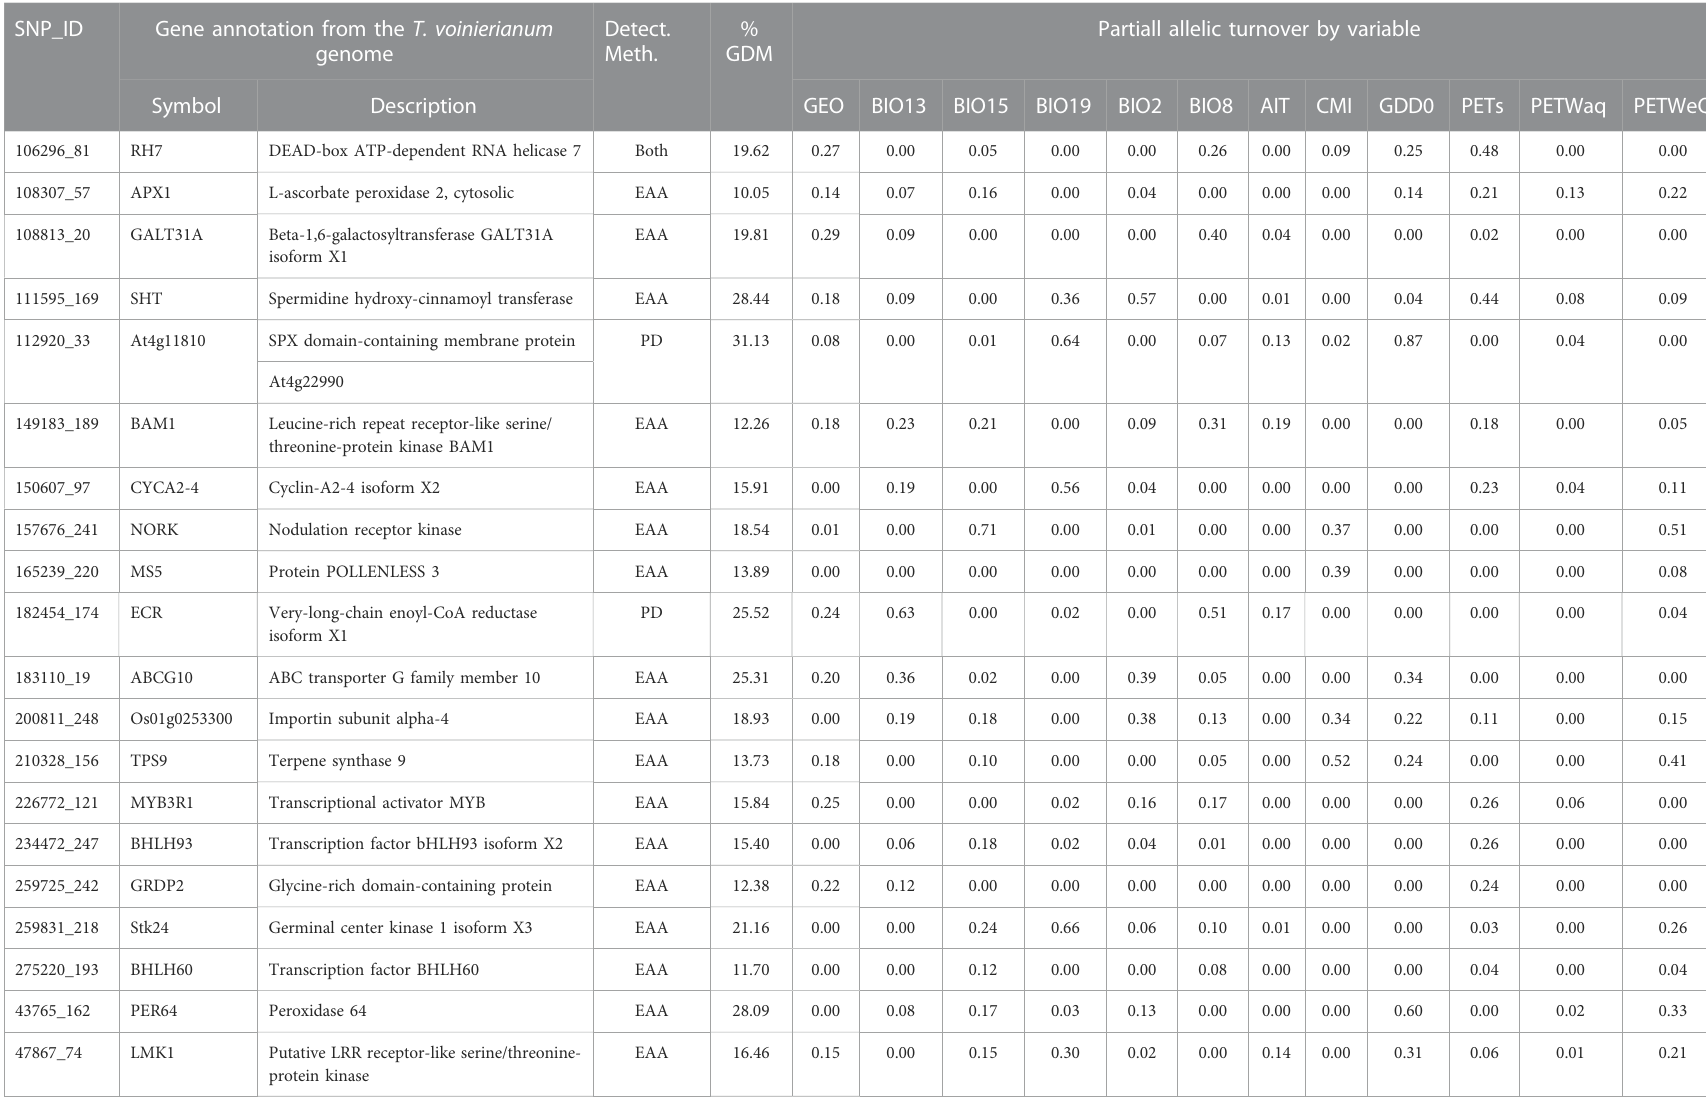
TABLE 3 Gene annotation and associated variables for potentially adaptive SNPs. SNP IDs, gene function on the T. voinierianum genome are shown. The detection method (PD/EA tests) and partial allelic turnover by variables predicted by GDM are listed for each annotated locus. The SNP presented had 1) higher allelic turnover responses associated with climate variables relative to geographic distance, and 2) a higher explained deviance (%) in GDMs than the reference SNP group. The climate variable de fi nitions are in Supplementary